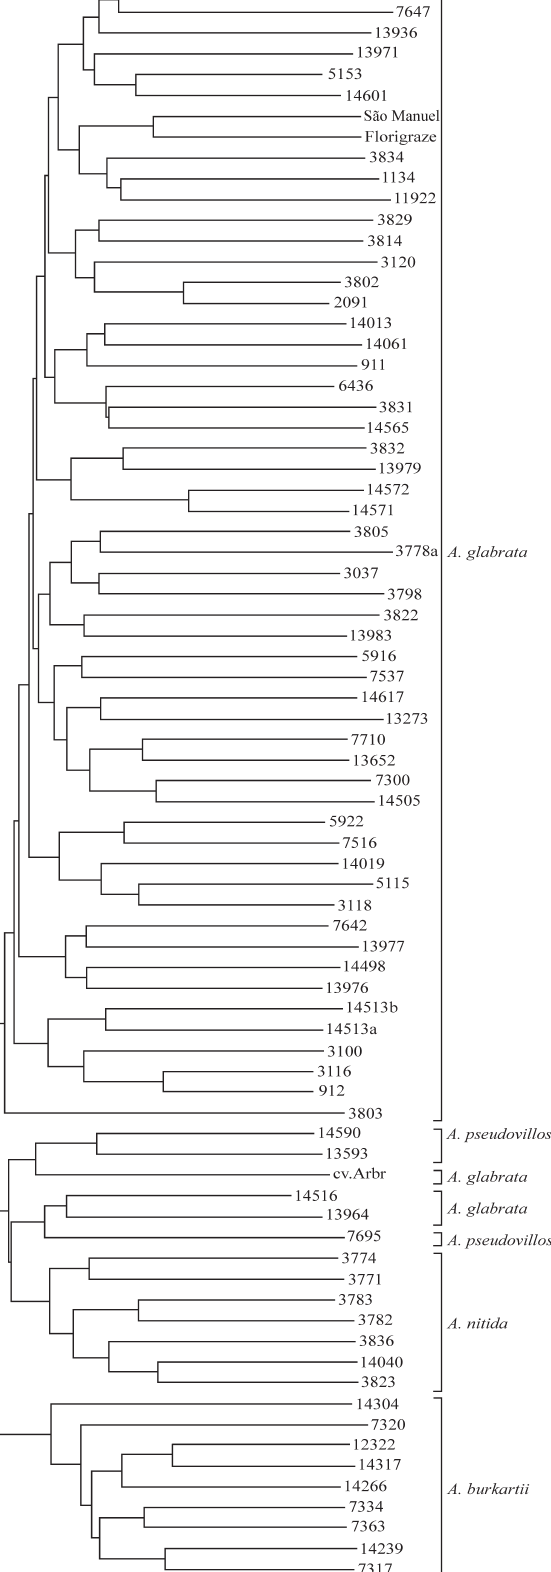
Figure 1 - Neighbor joining tree showing the relationships between acces- sions of the four Arachis species in section Rhizomatosae . The accession numbers are those shown in Table